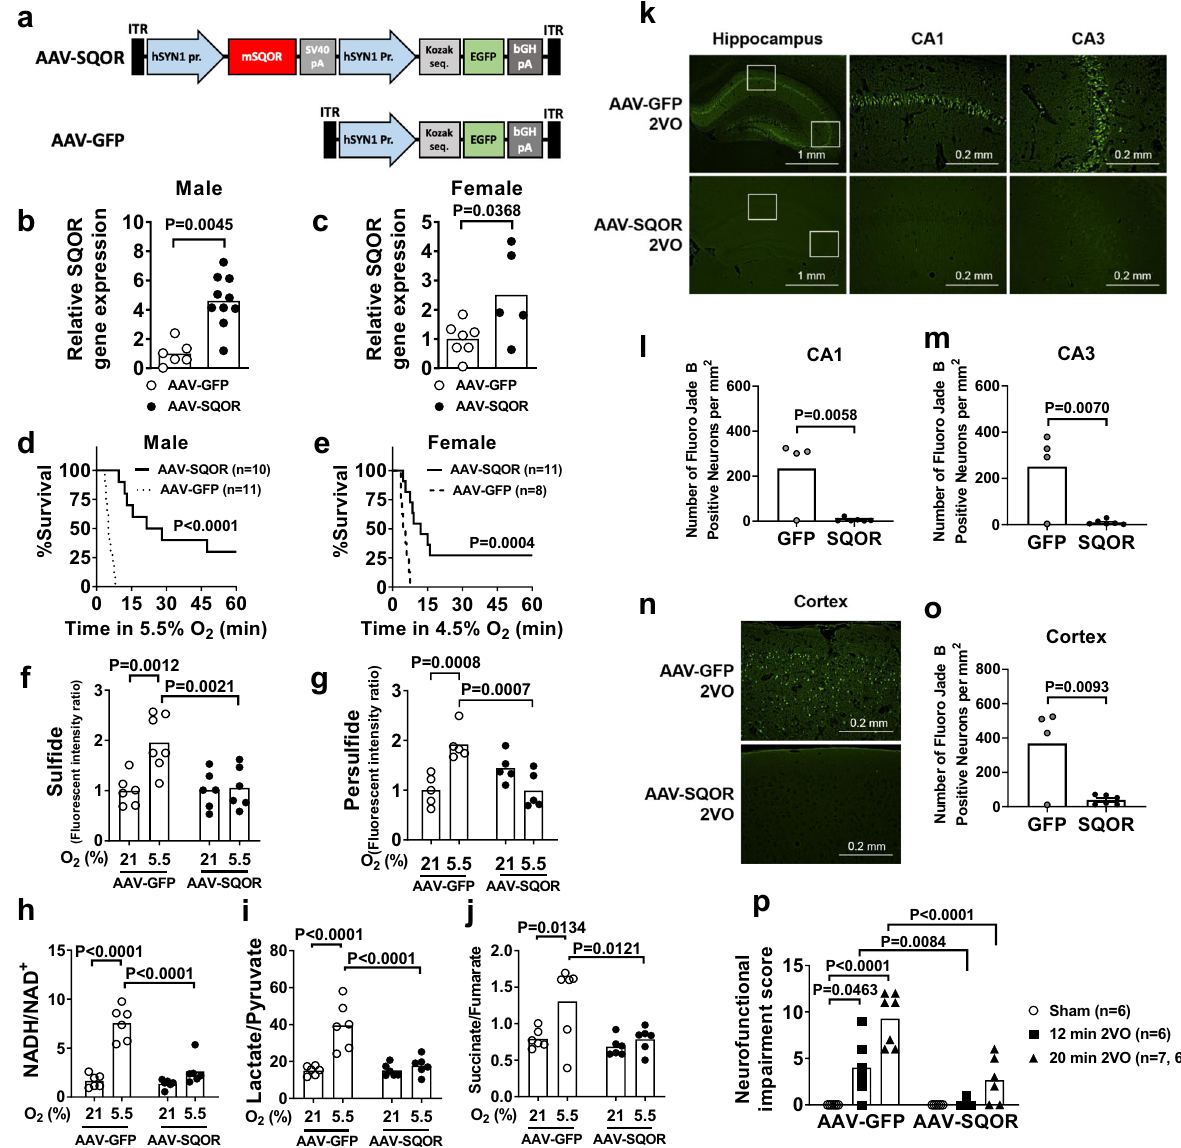
Fig. 6 Effects of SQOR expression in the brain of mice. a Structures of AAV containing mouse SQOR and enhanced GFP sequence under hSYN1 promoter (AAV-SQOR) and control AAV (AAV-GFP). SV40, simian virus 40. Relative SQOR mRNA expression levels in brains of 8-week-old b male ( n = 6, 10) and c female ( n = 7, 5) CD-1 mice transfected with AAV-GFP or AAV-SQOR on postnatal day 0. Survival curves of 8-week-old d male and e female CD-1 mice transfected with AAV-GFP or AAV-SQOR on postnatal day 0 and breathing 5.5% oxygen and 4.5% oxygen, respectively. Levels of f sul fi de ( n = 6, 7, 6, 6), g persul fi de ( n = 5 each), h the ratios of NADH/NAD + ( n = 6 each), i lactate/pyruvate ( n = 6 each), and j succinate/fumarate ( n = 6 each) in male mice transfected with AAV-GFP or AAV-SQOR and breathed 21% or 5.5% oxygen for 3 min. k Representative photomicrographs of Fluoro-Jade B (FJB)-stained brain sections focusing on hippocampal CA1 and CA3 regions of male mice transfected with AAV-GFP ( n = 4) or AAV-SQOR ( n = 6) and subjected to 2VO and reperfusion. Number of dead neurons in l CA1 and m CA3 regions of mice transfected with AAV-GFP or AAV-SQOR and subjected to 2VO ( n = 4, 6). n Representative photomicrographs of FJB-stained brain sections focusing on cerebral cortex region of male mice transfected with AAV-GFP ( n = 4) or AAV-SQOR ( n = 6) and subjected to 2VO and reperfusion. o Number of dead neurons in the cerebral cortex of mice transfected with AAV-GFP or AAV-SQOR and subjected to 2VO ( n = 4, 6). p Neurofunctional impairment score of male CD-1 mice transfected with AAV-GFP or AAV-SQOR and subjected to sham surgery or 12 or 20 min of 2VO ( n = 6, 6, 7, 6, 6, 7). Data are presented as mean and individual values. A two-tailed unpaired t -test